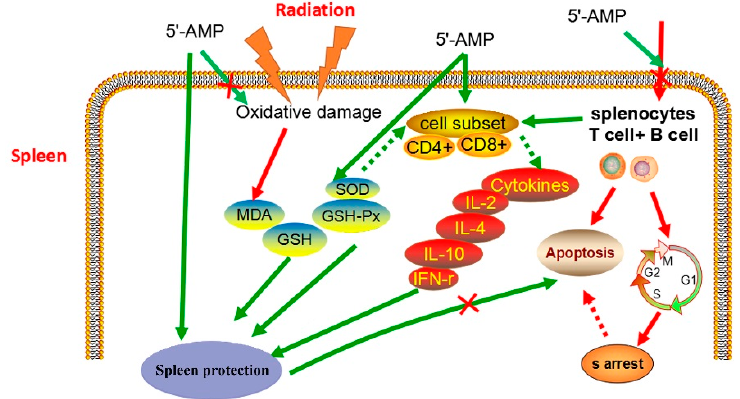
Figure 9. Proposed model for protective mechanism of 5 ′ -AMP on spleen tissues of γ -ray irradiated mice.